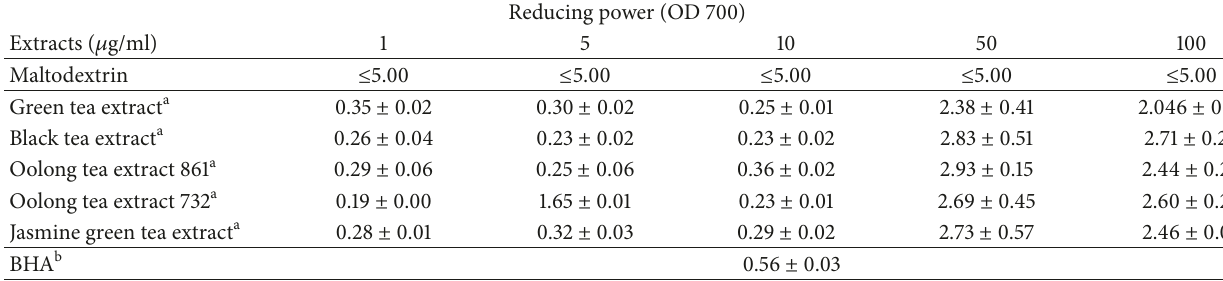
Table 3: Five different concentrations with reducing power of five tea